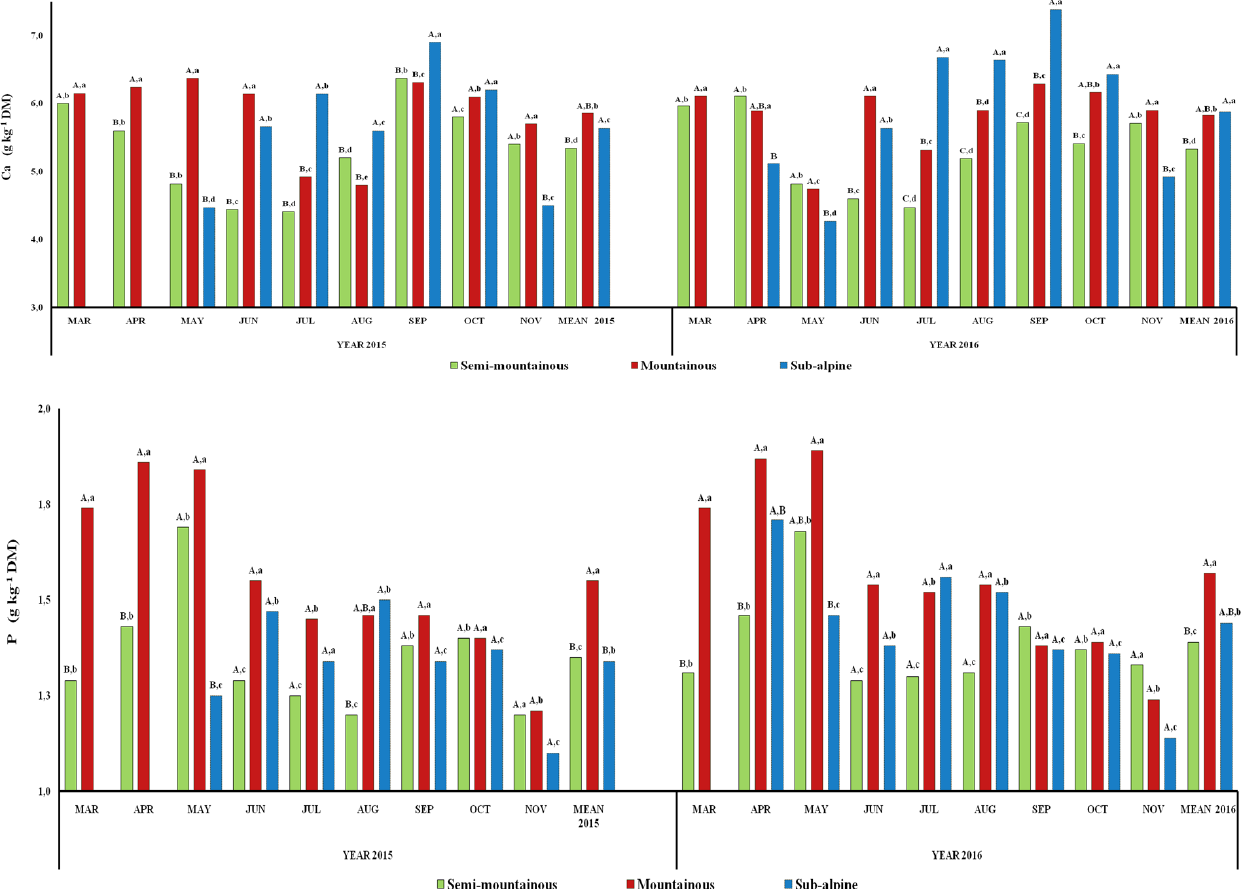
Figure 5. Interannual and monthly variation of herbage calcium and phosphorus contents (gkg − 1 DM) of the semi-mountainous, moun- tainous and sub-alpine grasslands in the Florina Prefecture, northern Greece. Means of the three grasslands between the 2-year experimental period followed by different letters (a–d) along the corresponding bar differ at P < 0 . 05. Means of the three grasslands in the same year of the experimental period followed by different capital letters (A–C) along the corresponding bar differ at P < 0 .